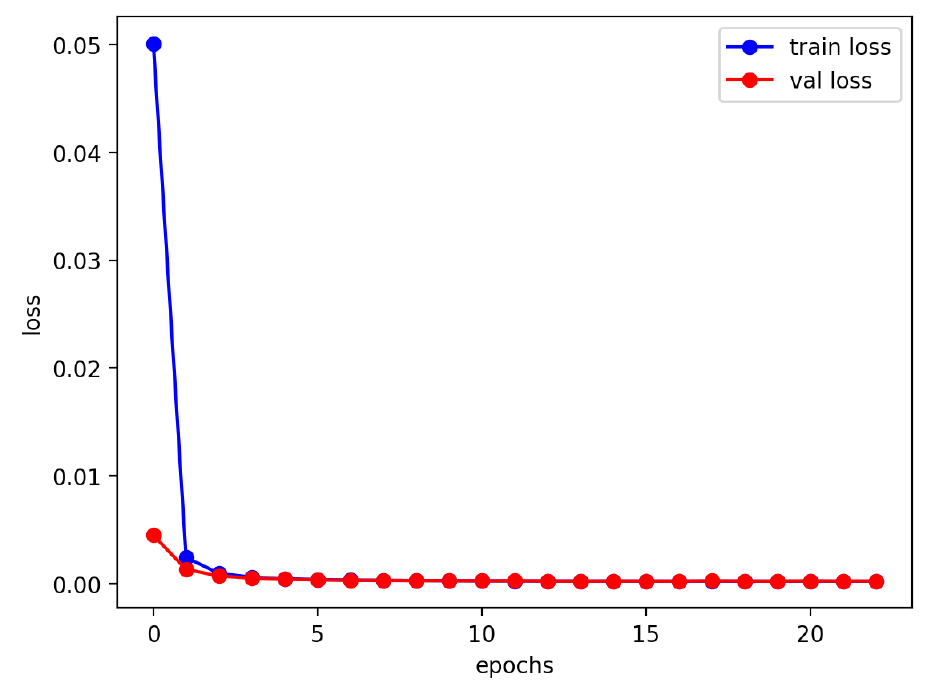
Figure 2. Entropy losses for the S&P 500 data with maturities from 31 December 2021 to 15 Decem- ber 2023.